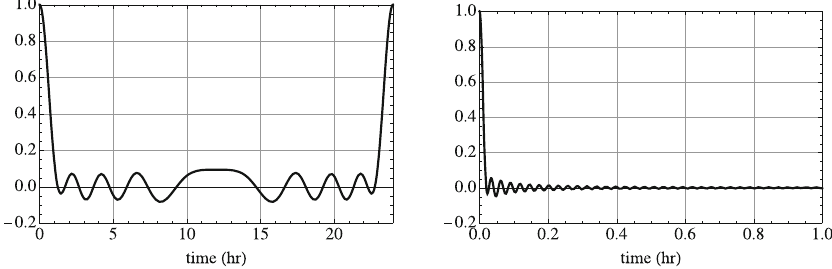
Fig. 42 Overlap function at f = 100 Hz for two virtual interferometers as a function of time. The left- hand plot is for a set of virtual interferometers located on Earth’s equator, associated with Earth’s daily rotationalmotion.The right-handplot isforasetofvirtualinterferometersat1AUfromtheSSB,associated with Earth’s yearly orbital motion. The first zero-crossing times in these two plots are consistent with the correlation times given in (5.57). Image reproduced with permission from Romano et al. (2015), copyright by